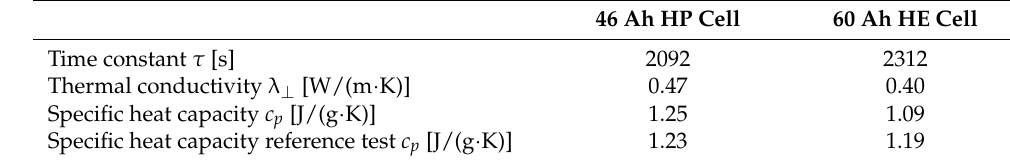
Table 2. Resulting data for the 46 Ah and the 60 Ah cell at T amb = 25 ◦ C and SOC =